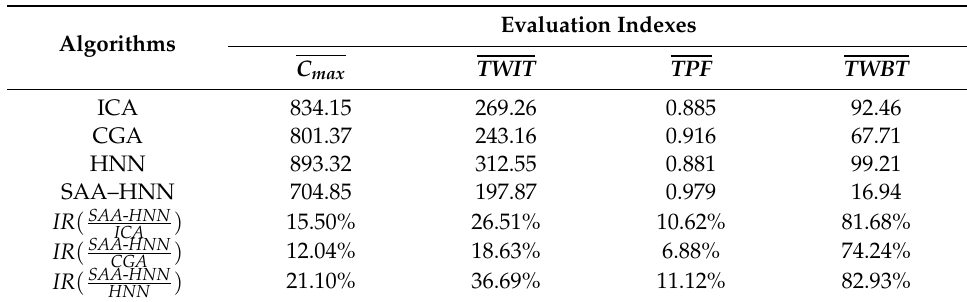
Table 6. Comparison of the evaluation indexes of four algorithms’ scheduling results (medium-scale